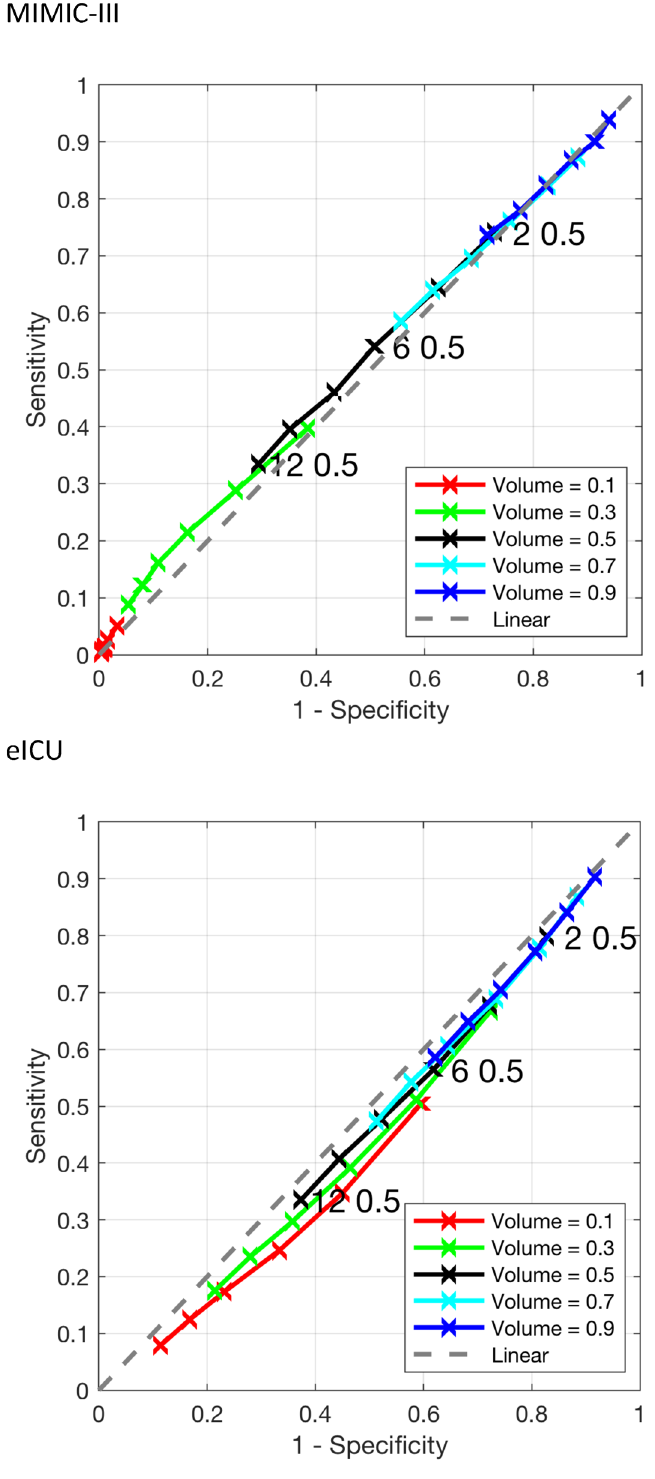
Figure 2. Sensitivity and specificity of various combinations of volume and time thresholds. Performance characteristics of urine output based definition relative to acute kidney injury based on creatinine for MIMIC- III (top) and eICU (bottom). The standard urine output based threshold is shown (labeled with “T = 6, V = 0.5” black line), along with variations on these thresholds. The color of the line corresponds to the volume threshold, while the ticks on each individual line segment represent time thresholds (from 2 to 12 h). Time thresholds increase traveling down and left along a curve. V volume (ml/kg/h), T time (h). The dashed line represents the ROC curve for a classification that is purely